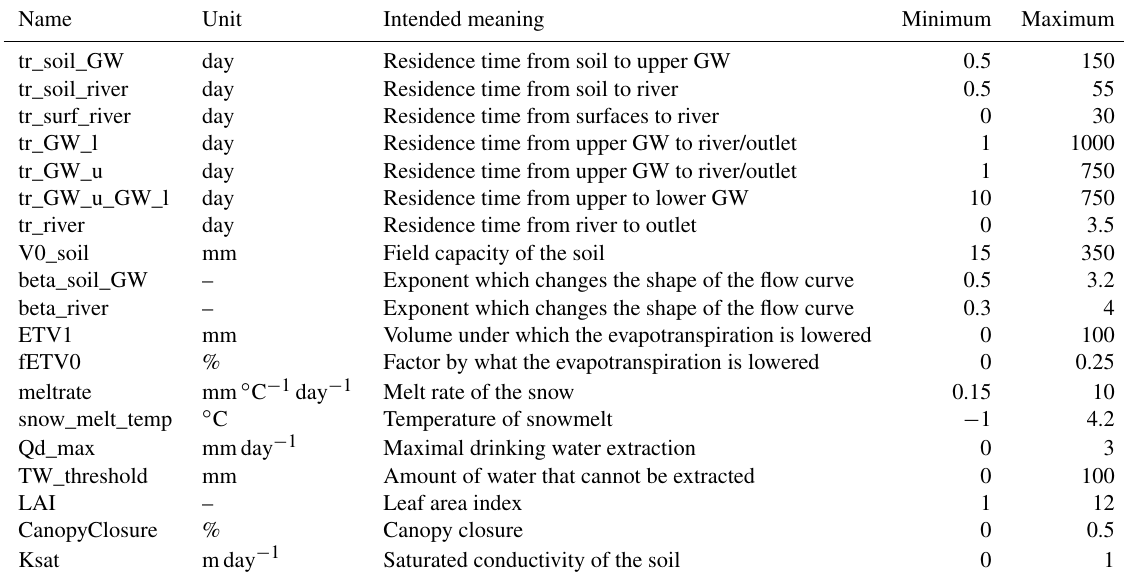
Table 2. Lower and upper parameters bounds of all models and their indented meaning. GW is